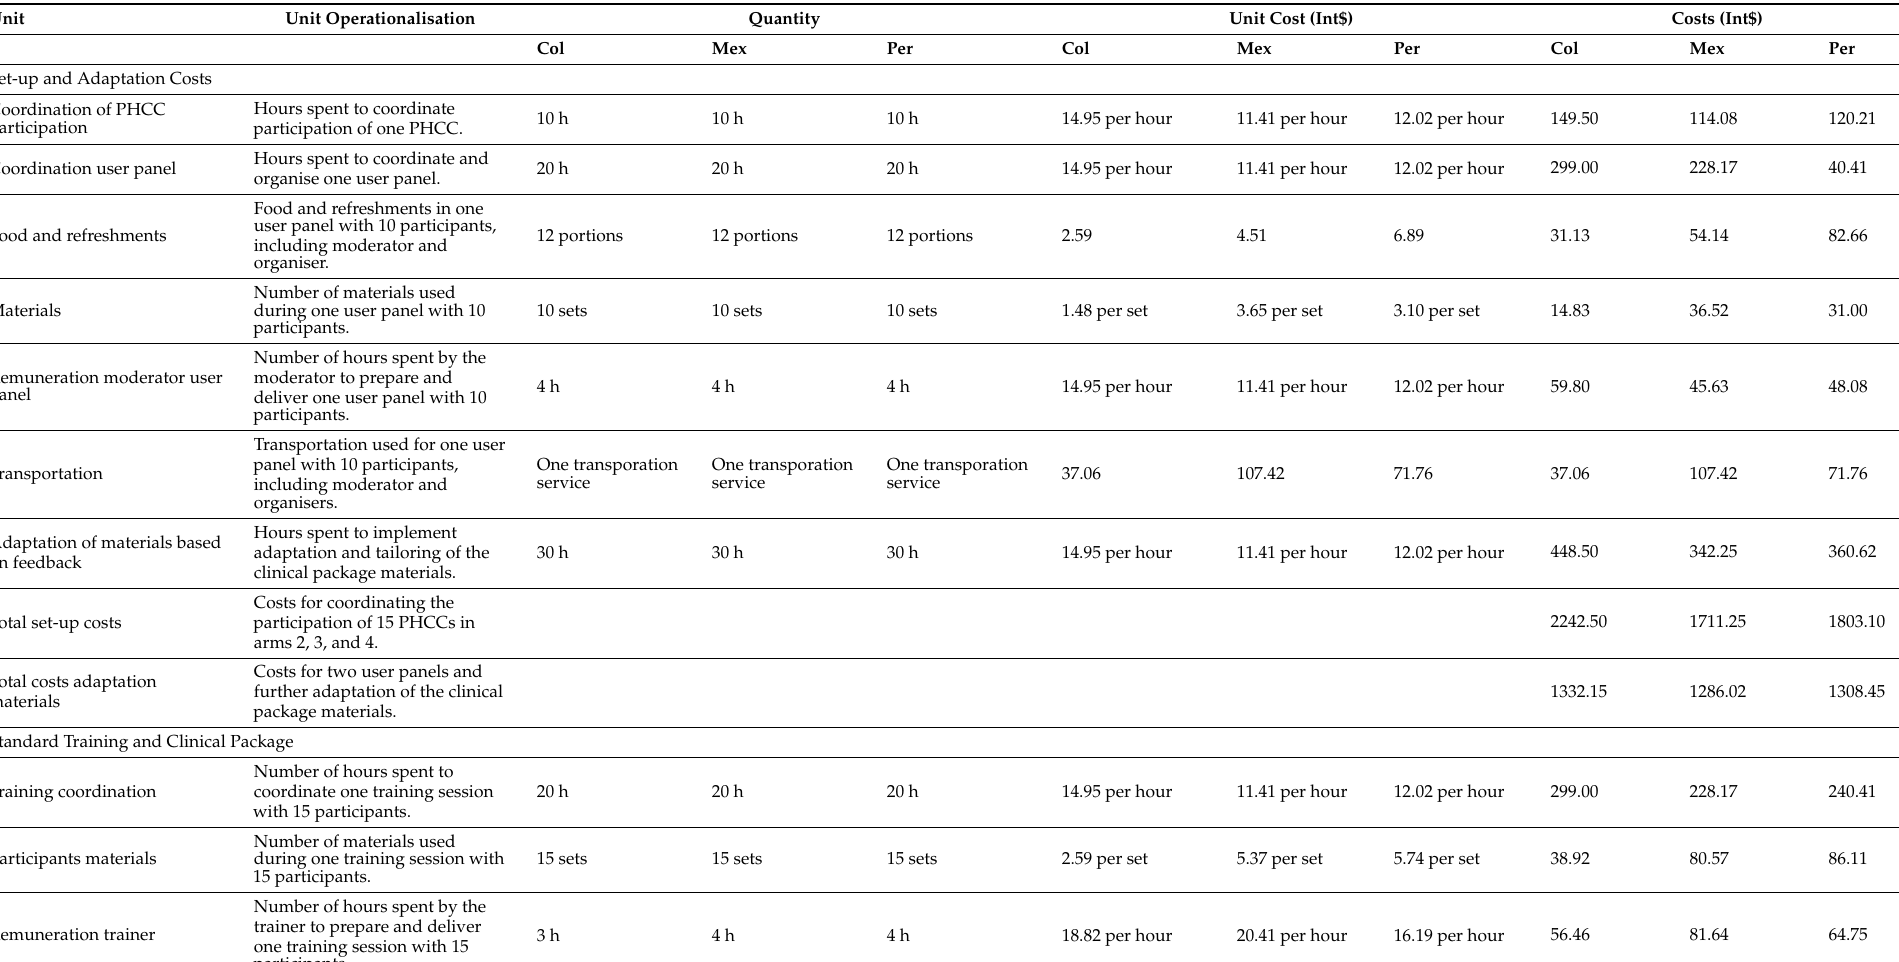
Table A6. Units, quantities, and costs of implementation